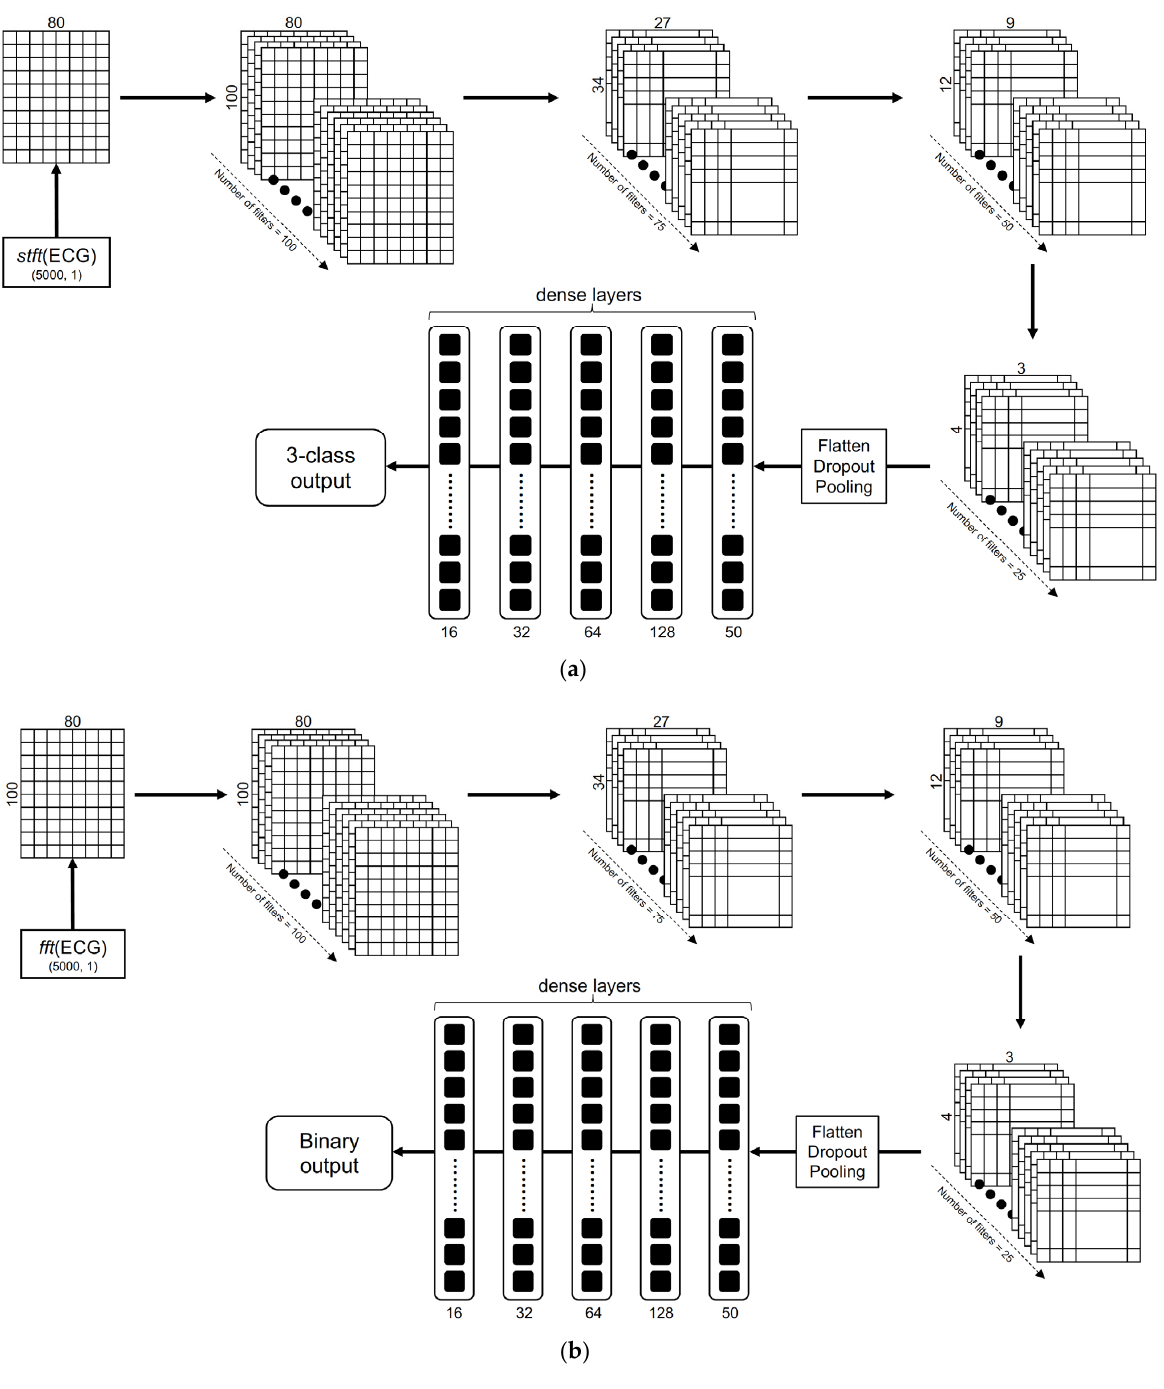
Figure 4. Structure of the 2D CNN classifiers in the one-step and two-step approaches: ( a ) one-step, 3-class 2D CNN classifier; ( b ) a binary 2D CNN classifier in the two-step approach. The training scheme of the three classifiers (the three-class classifier in the 1-step approach, the first-step classifier in the 2-step approach, and the second-step classifier in the 2-step approach) are shown in Figure 5. During training, the same number of data were randomly sampled repeatedly (nRepetitions = 20) from each class, and 20% of the training data were set aside for cross-validation in every iteration of the training step.